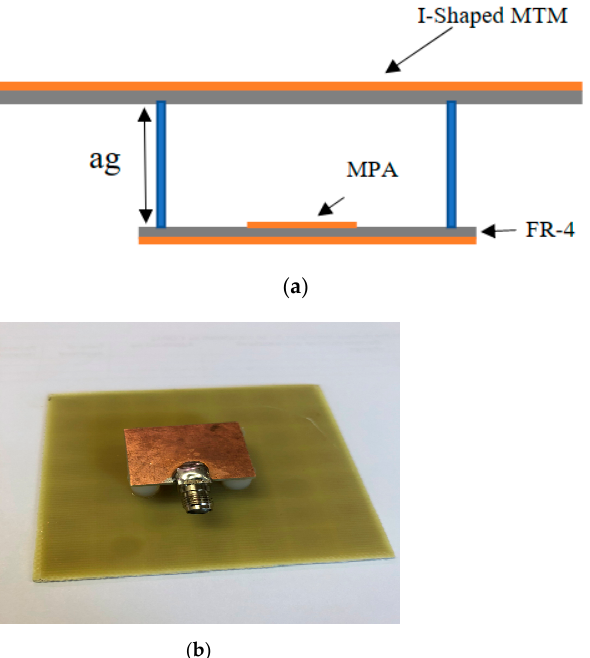
Figure 5. Proposed I-shaped MTM-based rectangular MPA ( a ) Geometrical configuration ( b ) Fabri- cated prototype.